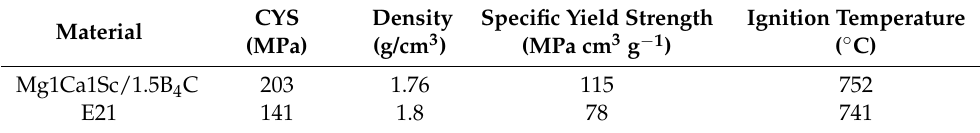
Table 2. Comparison properties between E21 and the Mg1Ca1Sc/B 4 C